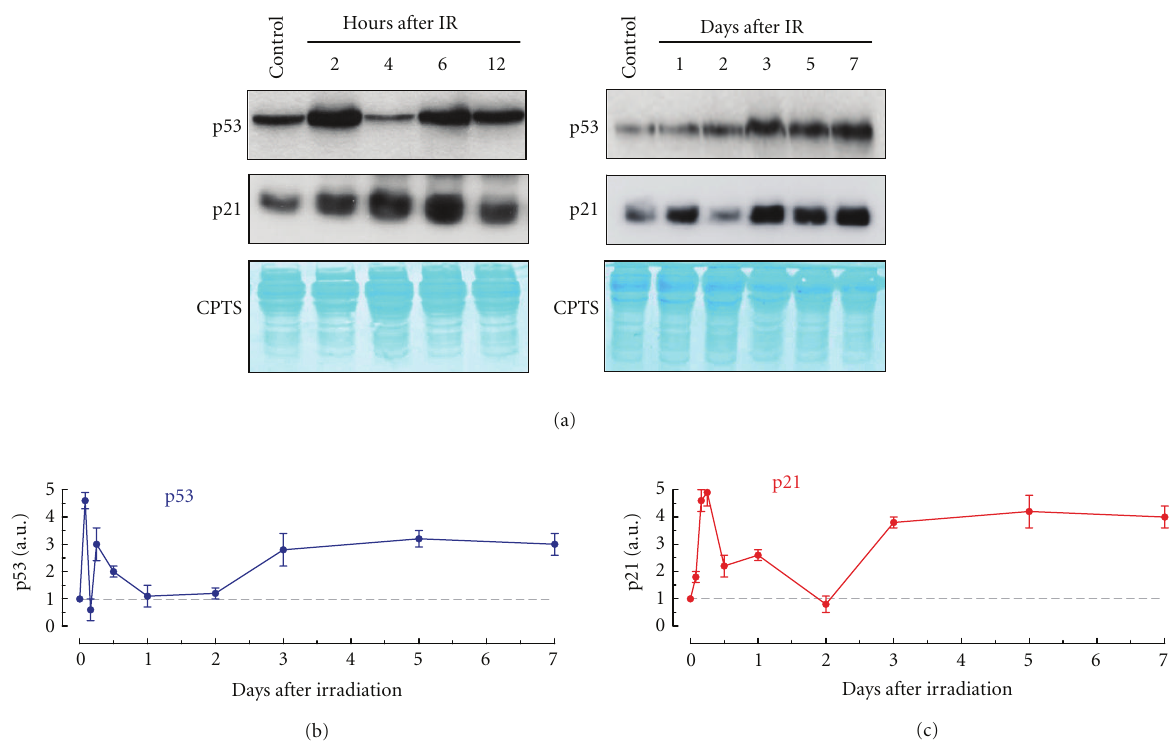
Figure 4: Dynamics of p53 and p21 protein levels in A172 (p53 wild-type) cells after exposure to ionizing radiation (IR; 5Gy). (a) Representative Western blots showing p53 and p21 levels before (control) and at indicated times post-irradiation. CPTS staining (blue) was used to confirm equal amount of protein loading in each well. (b and c) Relative amounts of p53 and p21 protein levels at indicated times after irradiation. The data are expressed as normalized p21 and p53 values for irradiated samples relative to the values for the corresponding controls (set at 1). Bars, SE. Western blot analysis of p53 and p21 protein levels was performed using our published techniques